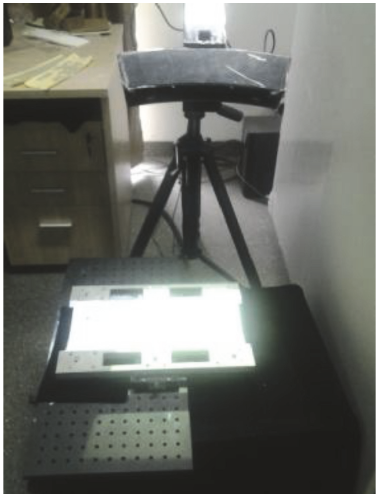
Figure 9: FEM model of the